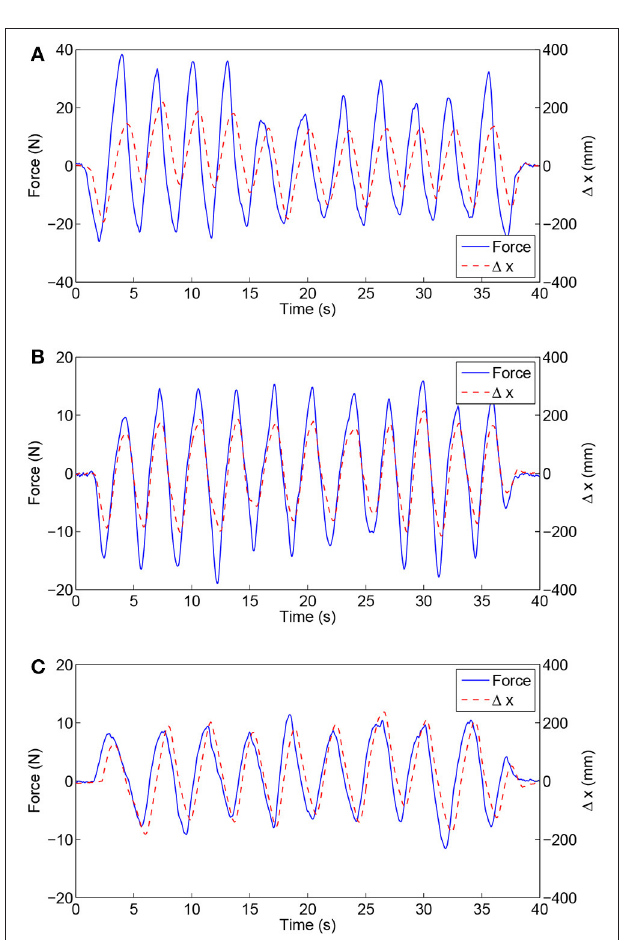
FIGURE 6 | Experimental results of free arm training tests conducted with healthy subject H1 with different admittance parameters. (A) Results under condition E1. (B) Results under condition E2. (C) Results under condition E3.